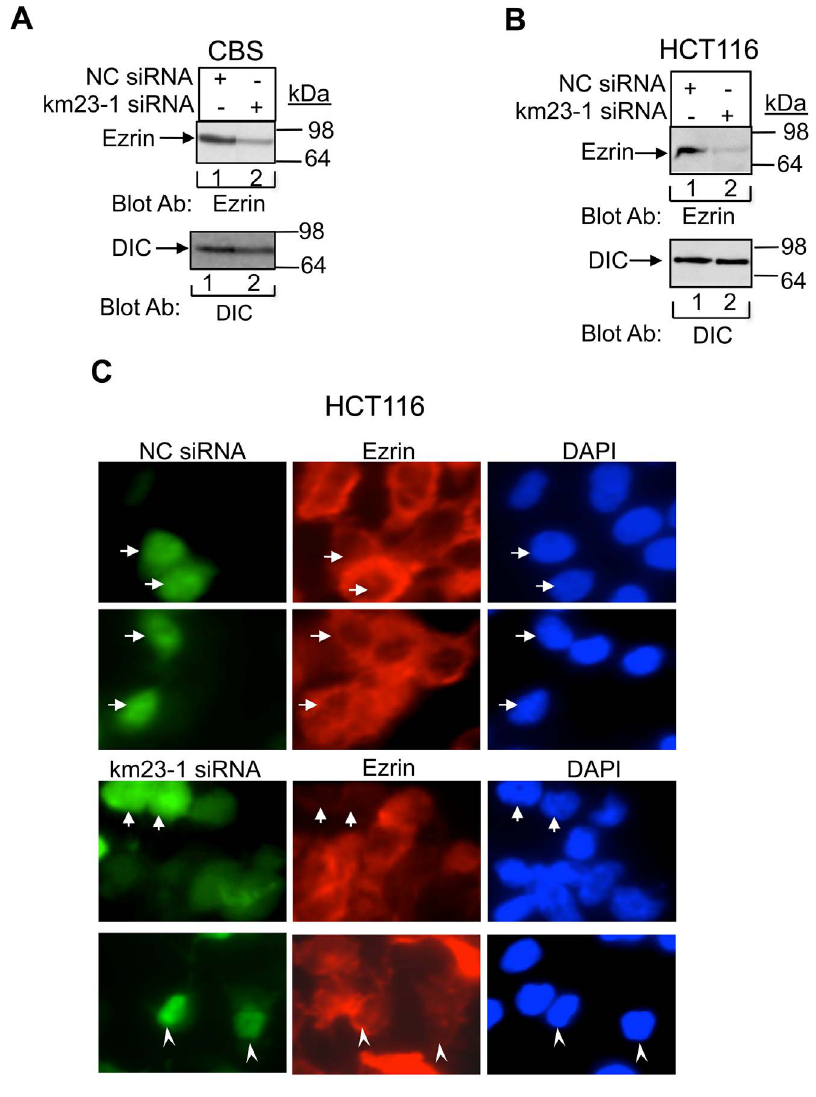
Figure 5. Depletion of km23-1 reduces Ezrin expression in human CRC cells. A: The cell lysates used for Fig. 1D were further subjected to Western blot analysis of Ezrin expression (Top). Bottom , DIC loading. B: HCT116 cells were infected with either pilenti-NC siRNA-GFP or the pilenti- km23-1 siRNA-GFP set. 24 h after infection, Western blotting was performed using the indicated antibodies. Top , confirms knockdown of endogenous km23-1. Bottom , DIC protein was assessed as a loading control. C: HCT116 stable pools that migrated through to the lower membrane in the Matrigel invasion assay were stained with an Ezrin Ab, followed by cy3-conjugated goat anti-rabbit IgG (red). DAPI staining permitted visualization of nuclei of individual cells (blue). GFP was used as a marker to designate cells transduced with siRNA (green). The cells were analyzed by an Olympus IX81 microscope at a magnification of 1000 6 with the appropriate filter sets.